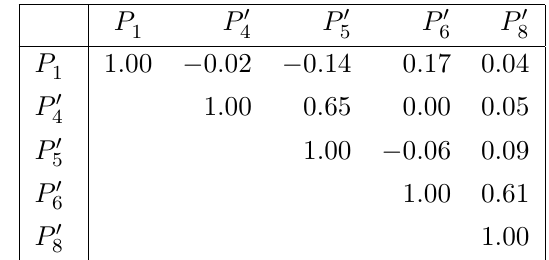
) parameters obtained for q 2 2 [0 : 04 ; 6 : 0] GeV 2 . 0